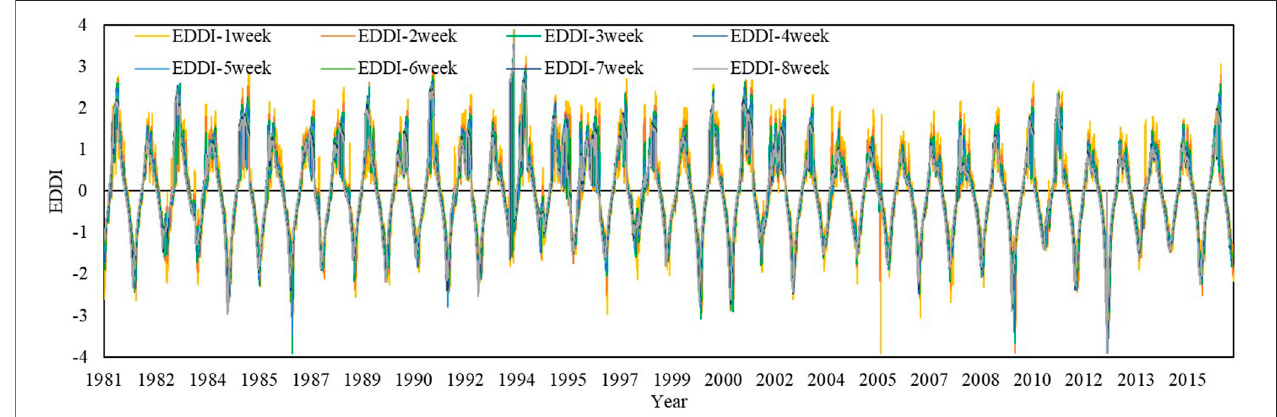
FIGURE. 9 | Temporal variations in the EDDI with 1 – 8-week timescales during 1981 – 2016.